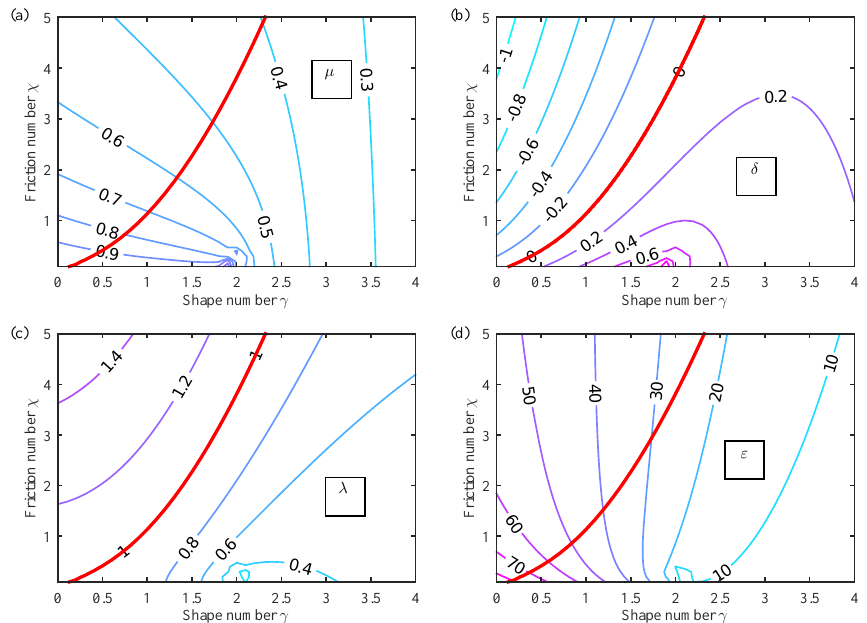
Figure 3. Analytical solutions of the four dependent dimensionless variables – (a) velocity number µ , (b) amplification number δ , (c) celerity number λ , and (d) phase lag ε – obtained by solving the set of Eqs. (6)–(16) as a function of the estuary shape number γ and the friction number χ for given values of ζ = 0 . 1, ϕ = 0 . 5, r S = 1. The thick red line represents the case for an ideal estuary ( δ = 0, λ = 1).